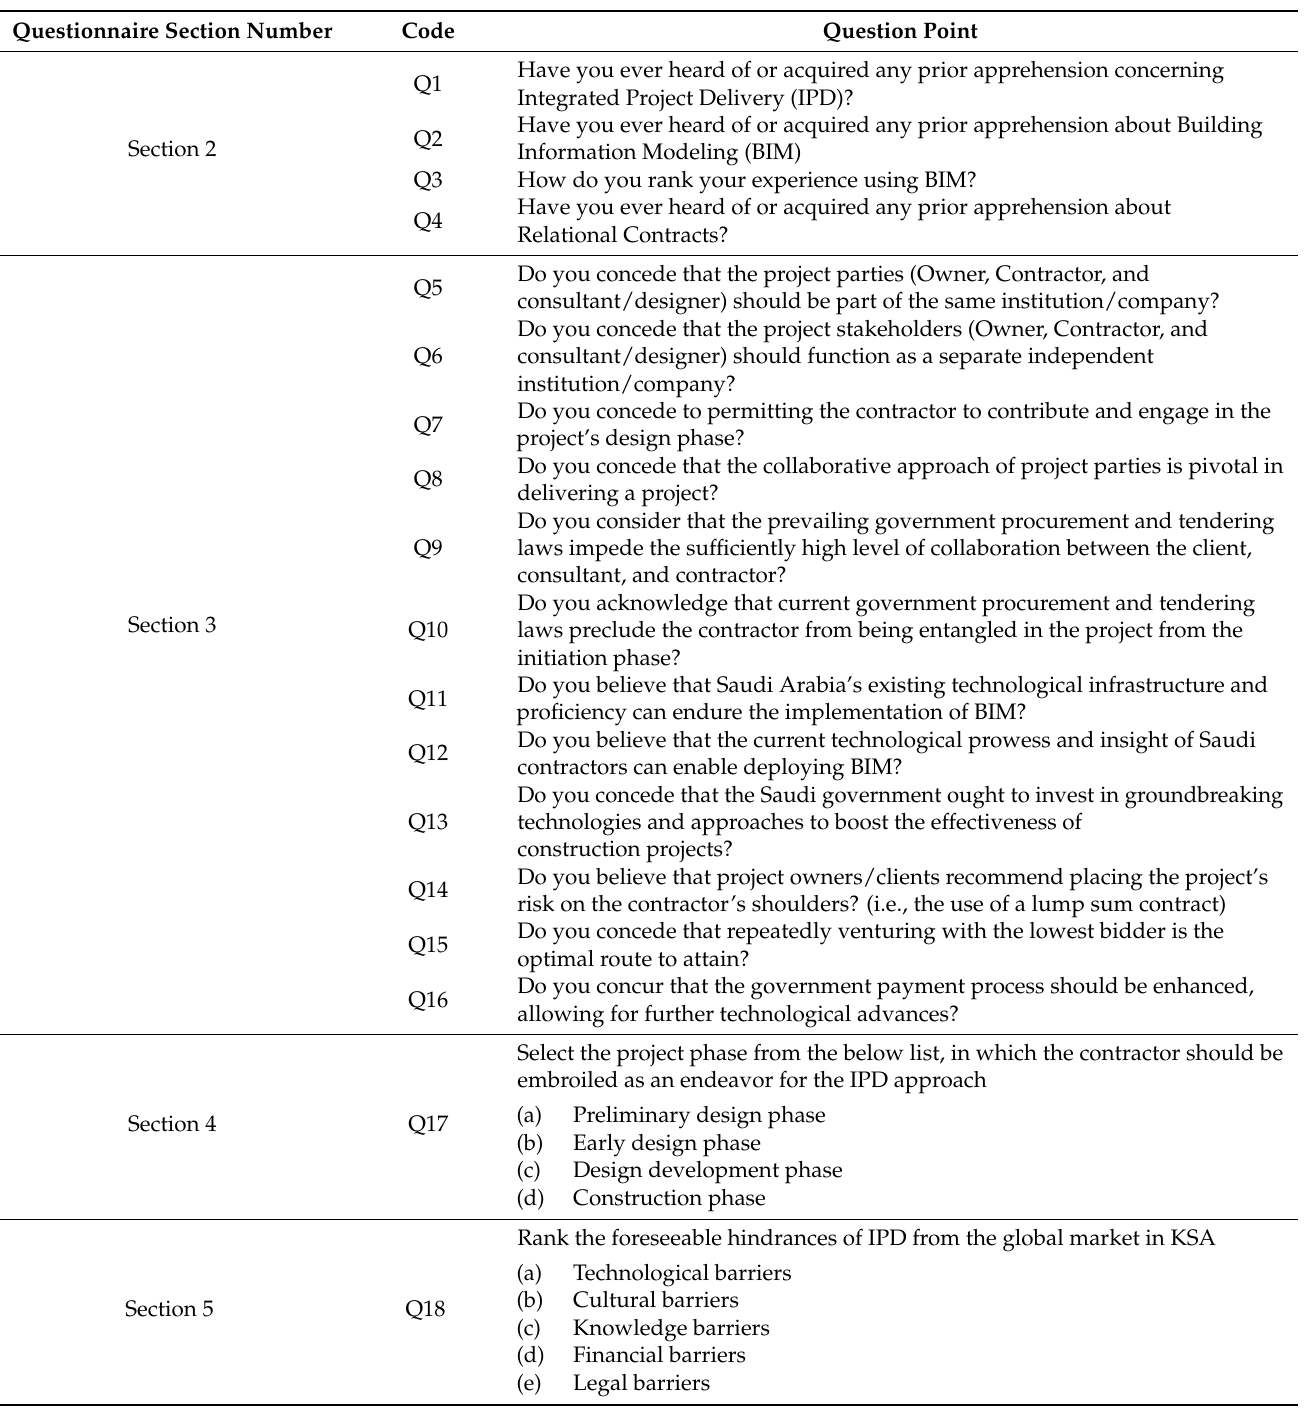
Table 1. Question points constituted in the questionnaire